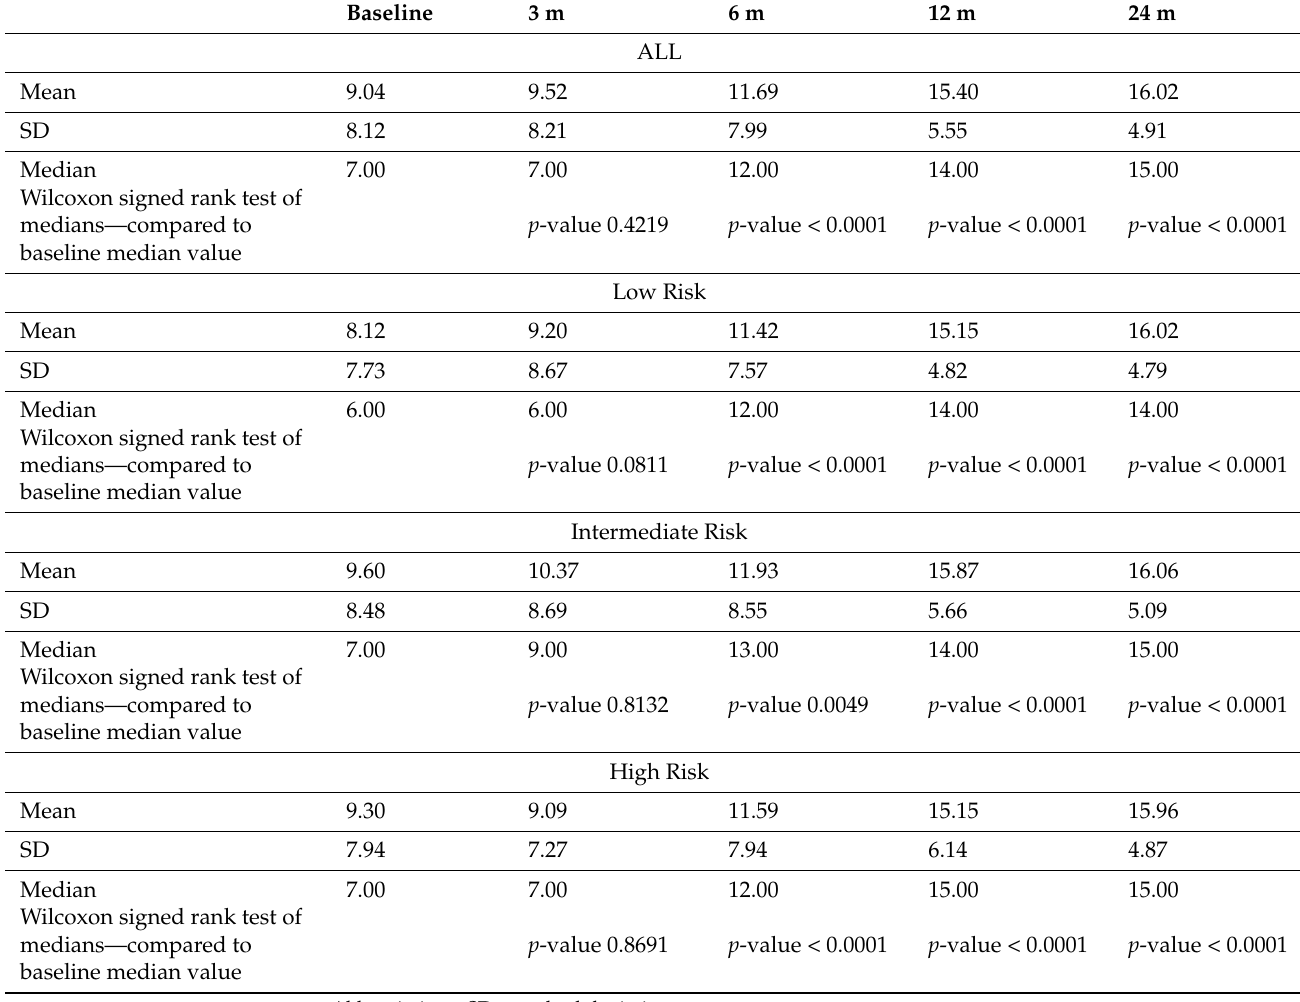
Table 2. Distribution of CES-D scores over time, and by prostate cancer risk group.